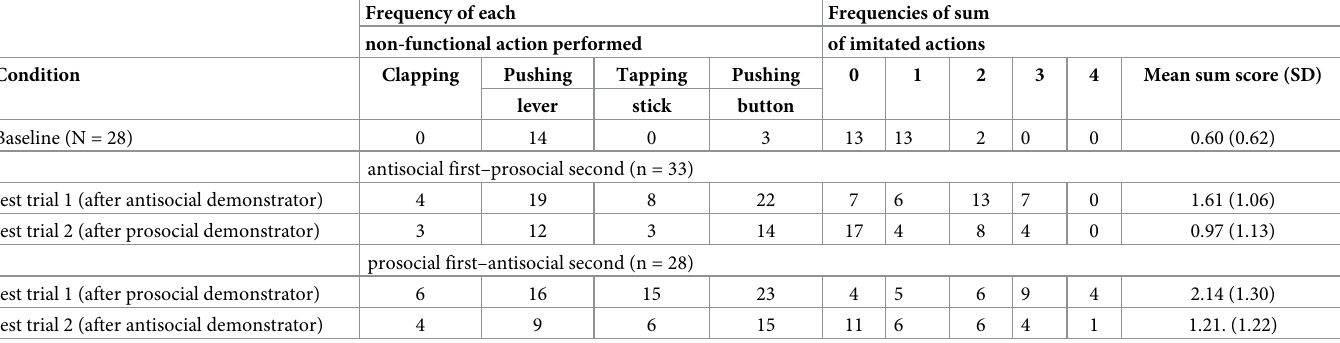
Table 1. Descriptive information: Number of children who re-enacted each of the four irrelevant actions, mean oi score and standard deviation for each test trial of each